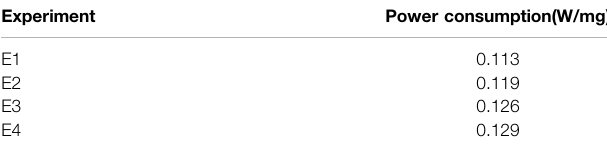
TABLE 5 | Power consumption for removing 1 mg of